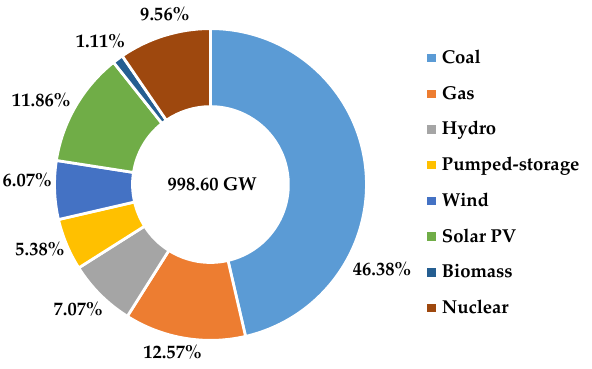
Figure 2. Proportions of installed capacities in the planning horizon.